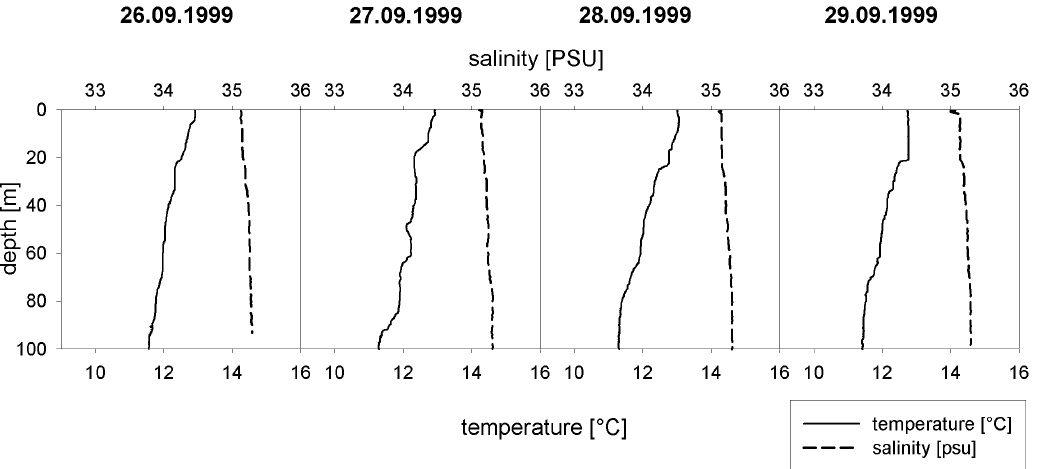
f ig . 2. – Temperature (solid line) and salinity (dashed line) profiles of the permanent station for the investigated period 26.09. - 29.09.1999. Profiles were taken at 19:00 [UTC] each